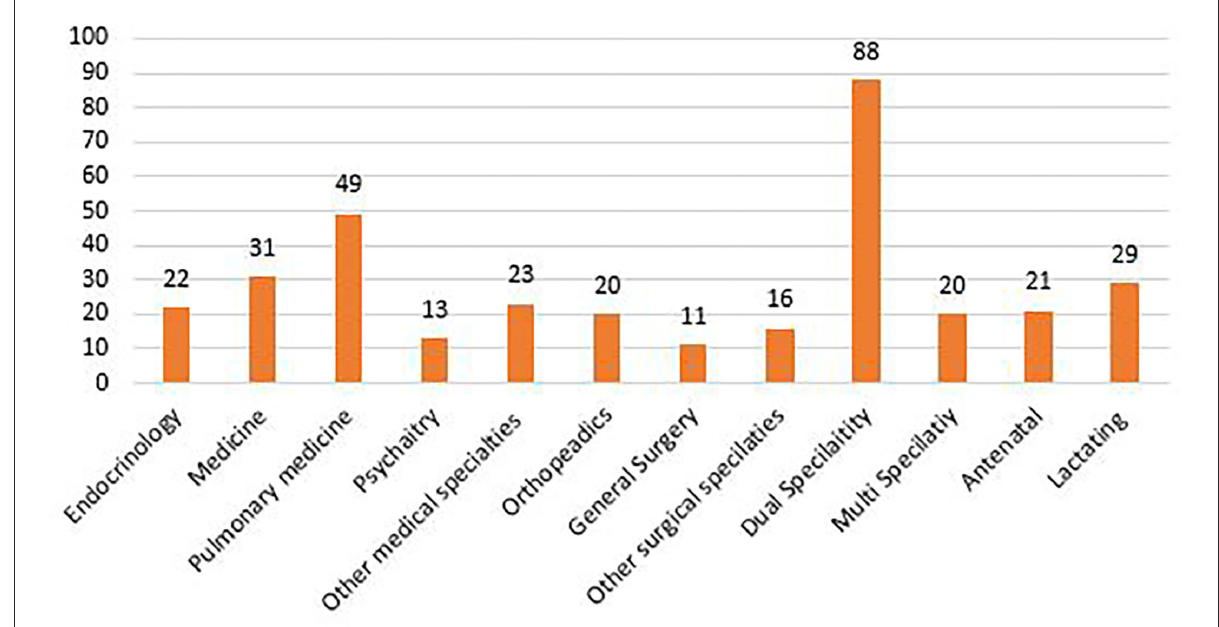
FIGURE3 Categorization of exemption requests based on medical/surgical specialities.